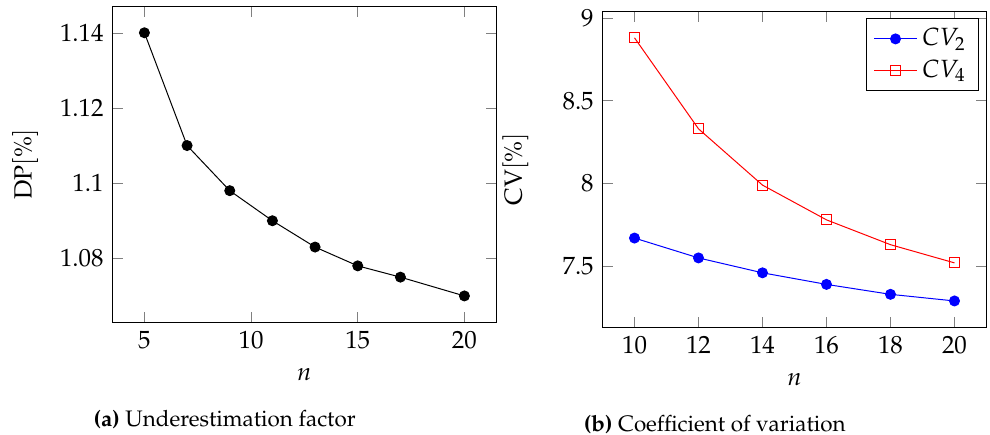
Figure 2. Performance metrics for the Pareto case (distribution parameters as in Table 5).